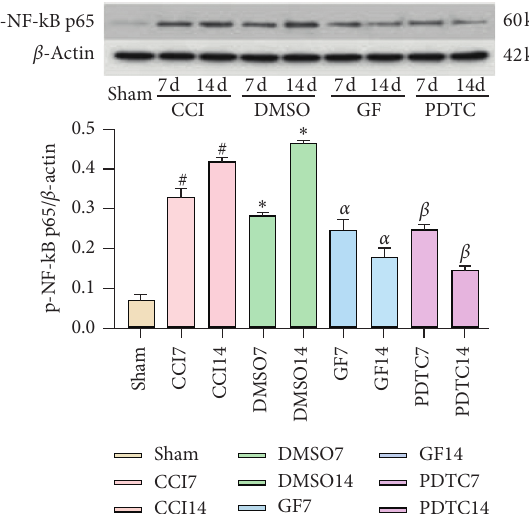
Figure 4: Inhibiting PKC and NF- κ B reduced CCI-induced P2X overexpression in DRGs. Data are expressed as mean ± SD and analyzed with one-way ANOVA tests and the S-N-Q test. # P < 0 . 05, ∗ P < 0 . 05 vs. Sham group, α P < 0 . 05, β P < 0 . 05 vs. CCI group, α P < 0 . 05 vs. DMSO